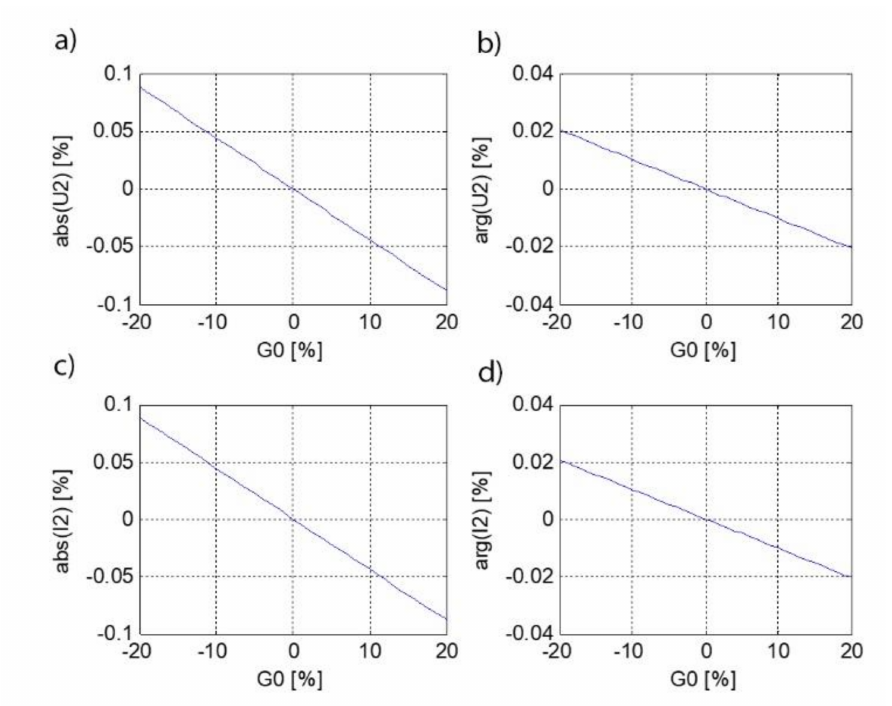
Figure 23. Changes of wave parameters depending on G 0 at f = 500 kHz; ( a ) U 2 voltage modulus, ( b ) U 2 argument, ( c ) I 2 modulus, ( d ) I 2 argument.